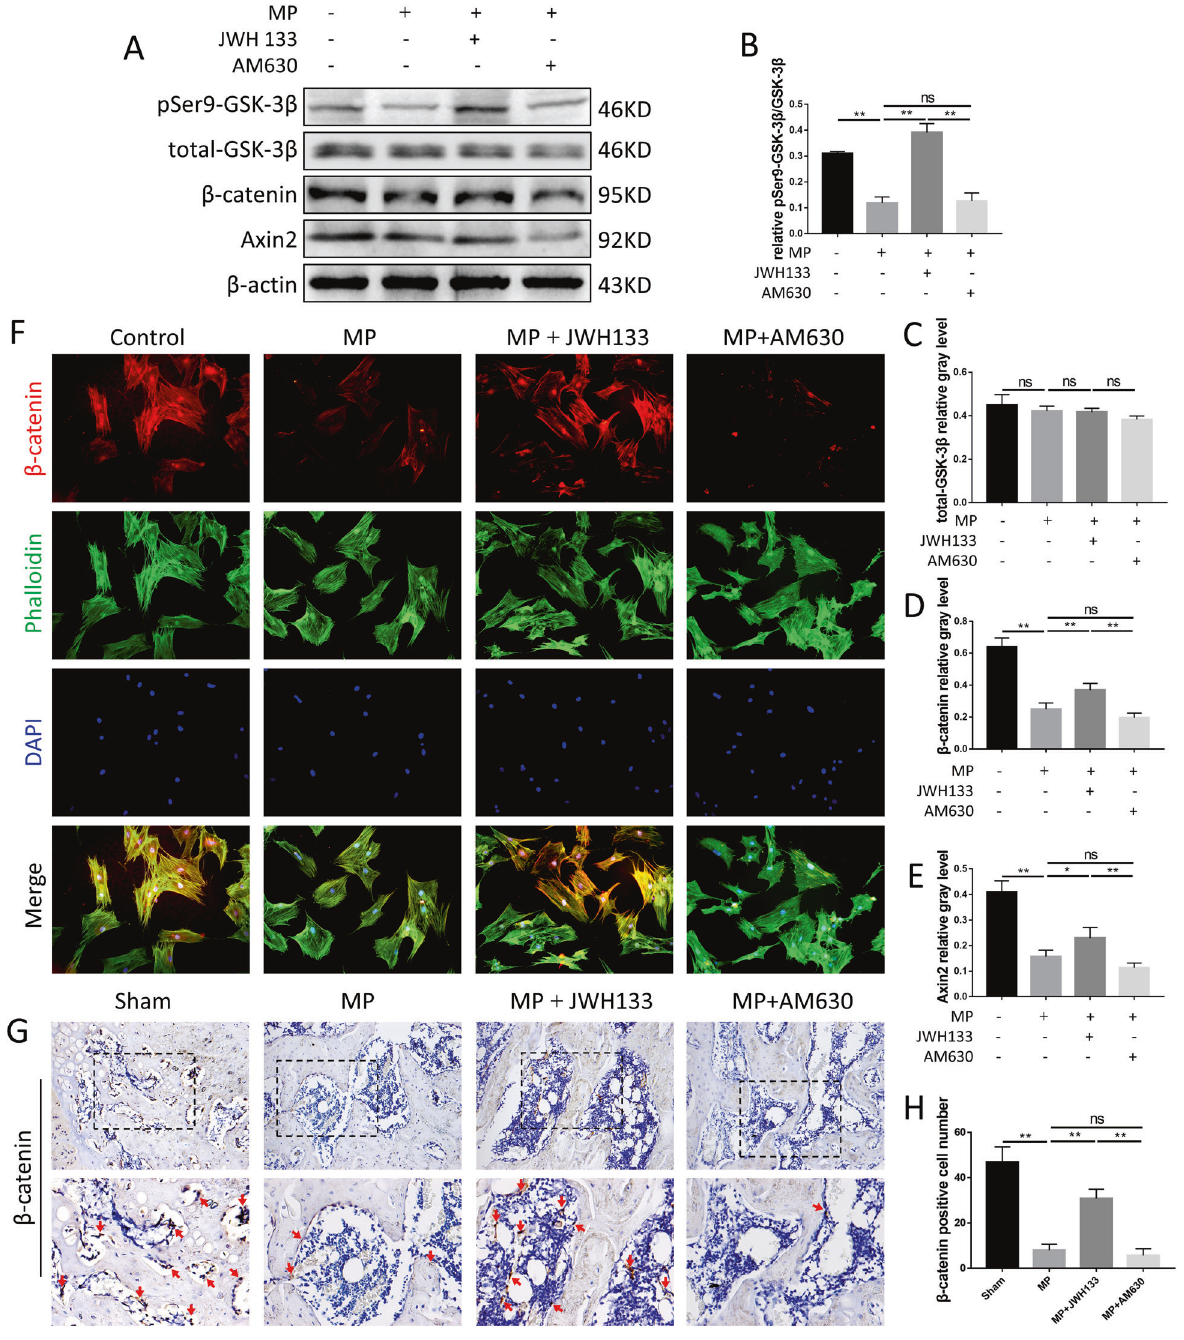
Fig. 5 Activity changes of GSK-3 β / β -catenin signaling pathway in vitro and in vivo. A – E Expression levels of pSer9-GSK-3 β , total GSK-3 β , Axin2, and β -catenin, n = 3 per group. F Immuno fl uorescence staining, red ( β -catenin), green (phalloidine), blue (nuclei). G , H Immunohistochemical staining and analysis for β -catenin, n = 10 per group (data are shown as mean ± SD, * p < 0.05; ** p < 0.01; ns, not signi fi perfusion. We created 3D models of the blood vessels in femoral endothelial growth factor (VEGF) is highly consistent with the head and quanti fi ed the volume of blood vessels (Fig. 7F, G). The osteogenic marker Runx2 (Fig. 7A – C). Runx2 and VEGF were both results showed that GC intervention severely damaged the vascular perfusion range and volume of the femoral head, and JWH133 alleviated this phenomenon. To further clarify the effect of CB2 and GCs on angiogenesis, we applied human umbilical vein endothelial cells (HUVECs) to assess endothelial cell function in vitro. We performed CCK8 assay on HUVECs and found that MP concentration was positively